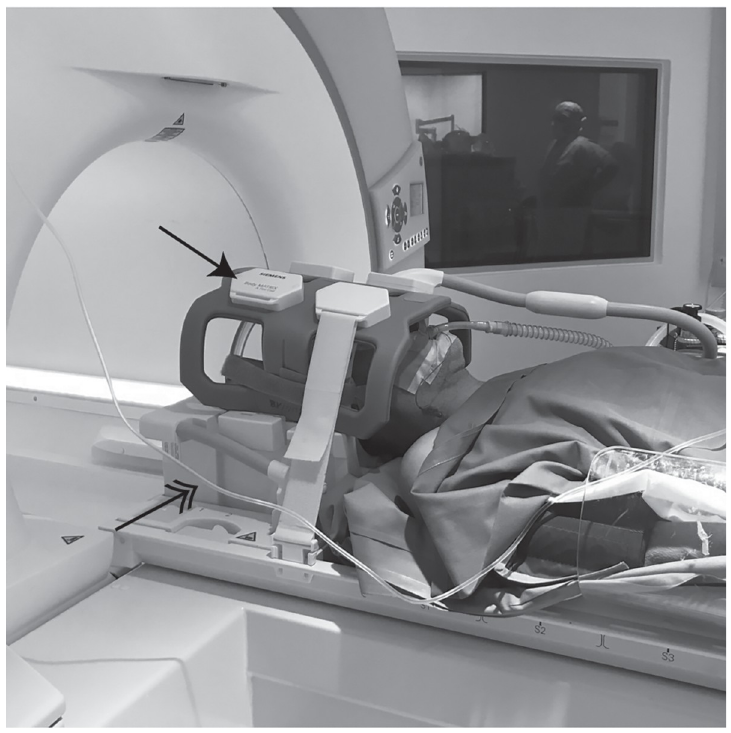
Fig 1. Positioning of the patient in the iMRI-scanner and setup of coils. The head of the patient with mounted frame and localizers is placed into the lower half of the 4-channel send/receive coil (double arrow). Due to the fact that the standard head coil (upper and lower part) does not accommodate the whole package, a flexible coil is used as upper half (black single arrow). This coil assembly was tested extensively prior to commissioning of the iMRI and yields good signal-to-noise